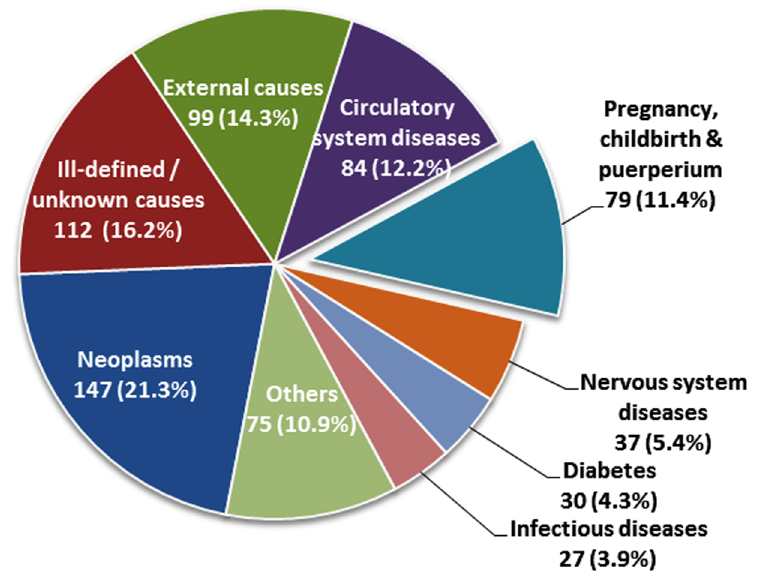
Fig 3. Causes of deaths among WRA (N =